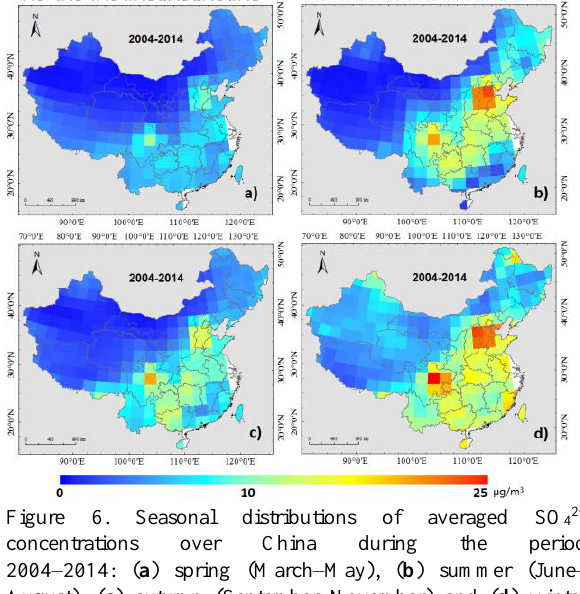
Figure 6. Seasonal distributions of averaged SO 42− concentrations over China during the period 2004–2014: ( a ) spring (March–May), ( b ) summer (June– August), ( c ) autumn (September–November) and ( d ) winter (December–February).